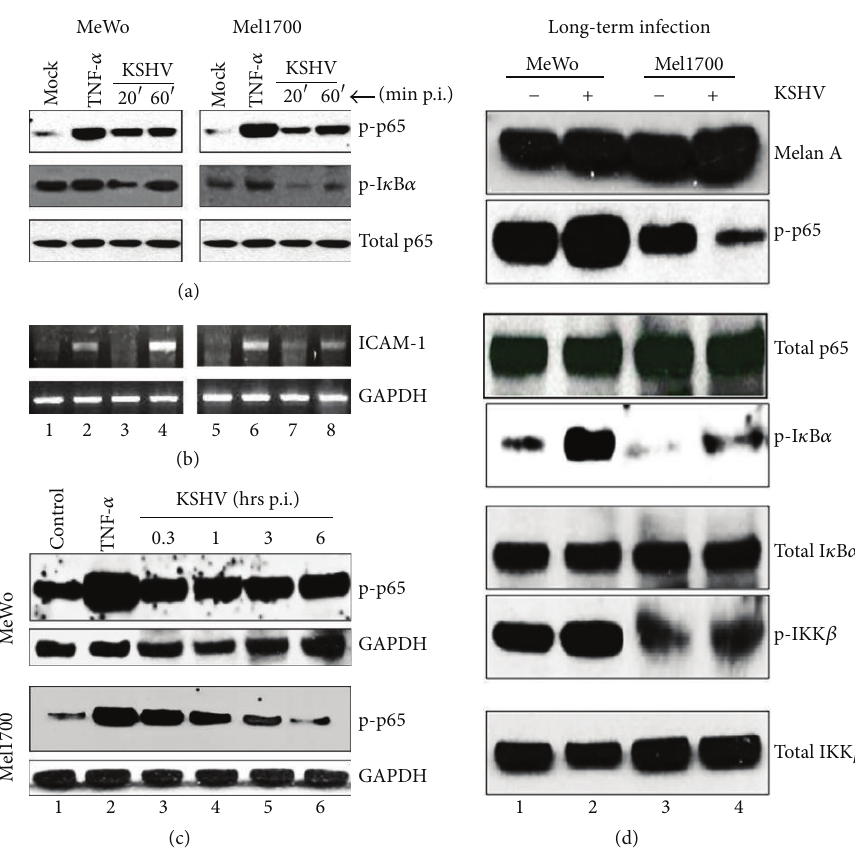
Figure 6: Early activation of NF- 𝜅 B signaling during acute infection with rKSHV.219 is sustained in MeWo cells, but subsequently limited in Mel1700 cells following long-term infection. (a) MeWo and Mel1700 cells either mock-infected, treated for 20 min. with TNF- 𝛼 , or infected with rKSHV.219 for 20 and 60min. were used in western blot analysis for phosphorylated NF- 𝜅 B p65. Mock-infected cell lysates were used to determine baseline levels of phosphorylated NF- 𝜅 B p65, whereas lysates from cells treated with TNF- 𝛼 served as positive controls for activation of NF- 𝜅 B p65. Total NF- 𝜅 B protein was used as an internal loading control. (b) Total RNA from half of the same cells used in (a) was used for RT-PCR amplification of the NF- 𝜅 B-controlled ICAM-1 gene. (c) MeWo cells (top) and Mel1700 cells (bottom) either mock- infected (control), TNF- 𝛼 -treated, or infected with rKSHV.219 for 0.3 h, 1h, 3 h, or 6h were used in western blot analysis for phosphorylated NF- 𝜅 B p65. (d) Western blot analysis of the phosphorylation levels of key components of the NF- 𝜅 B-signaling pathway in long-term cultures of uninfected ( − ) and infected (+) MeWo and Mel1700